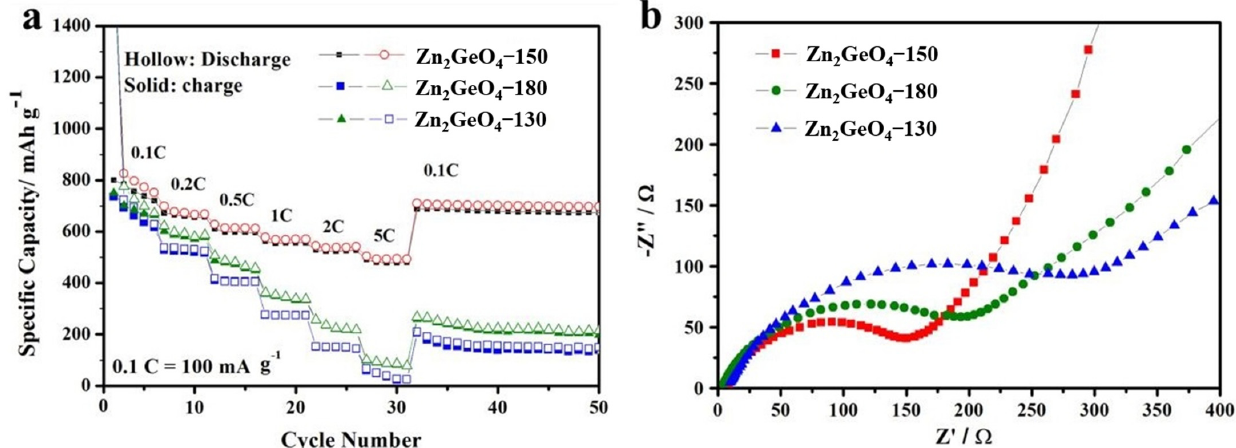
Figure 6. ( a ) Rate performances of Zn 2 GeO 4 -130, Zn 2 GeO 4 -150 and Zn 2 GeO 4 -180 at di ff erent current rates. ( b ) EIS spectra of three electrodes. rates. ( b ) EIS spectra of three electrodes. Table 1. Comparison of electrochemical properties of Zn 2 GeO 4 and relative metal oxide